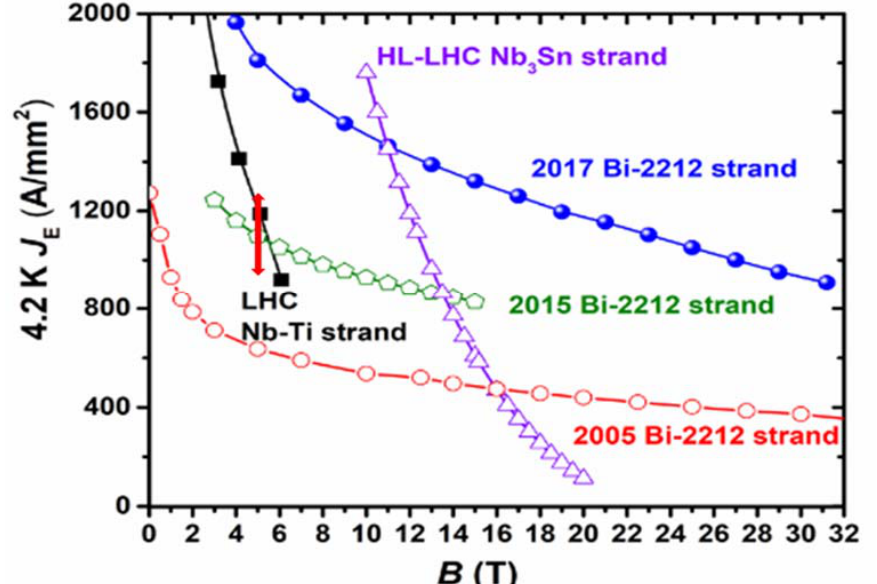
Figure 7. Bi2212 wire J e as compared with the LHC NbTi and HL ‐ LHC Nb 3 Sn wire specifications [10]. The 2005 curve represents best performance in the 2000s for Bruker ‐ OST wires with Nexans powder;